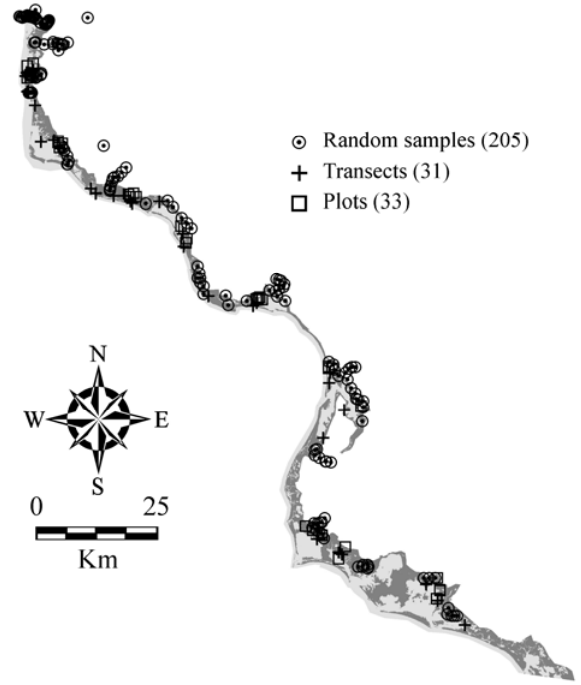
Figure 2. Training samples used to establish thematic categories, and to select training